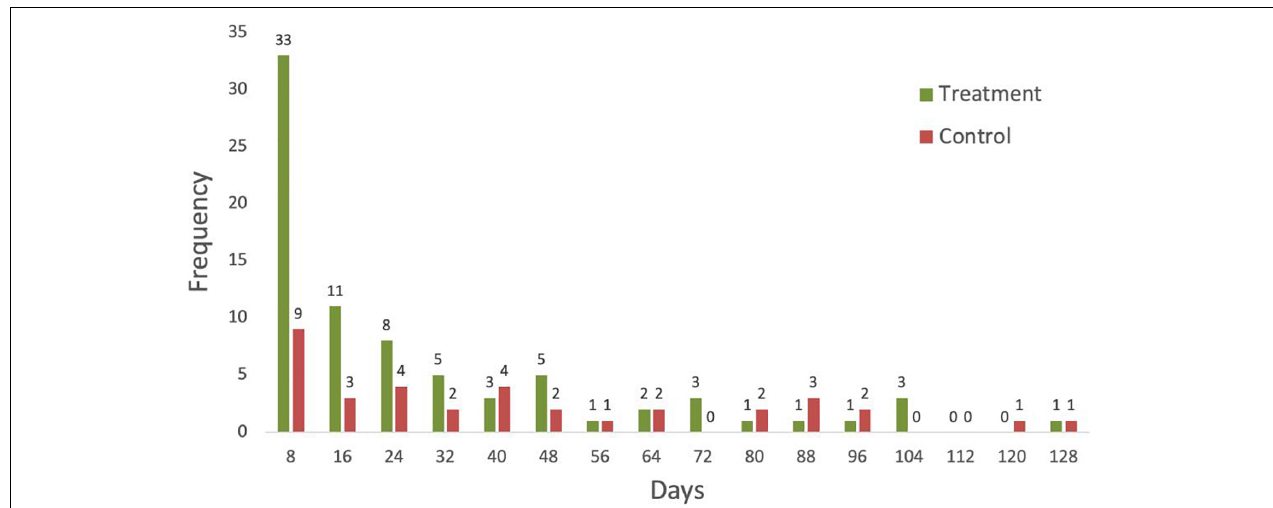
FIGURE 3 | Summary of germination frequency of P . microphylla seeds in the primary study involving the rattlesnakes ( Crotalus atrox ). Five trials were conducted and each one lasted 128 days. Germination (days) was calculated as the period from the day of feeding until the appearance of the radicle. The histogram was generated using the Histogram function in Excel version 16.48 Data Analysis